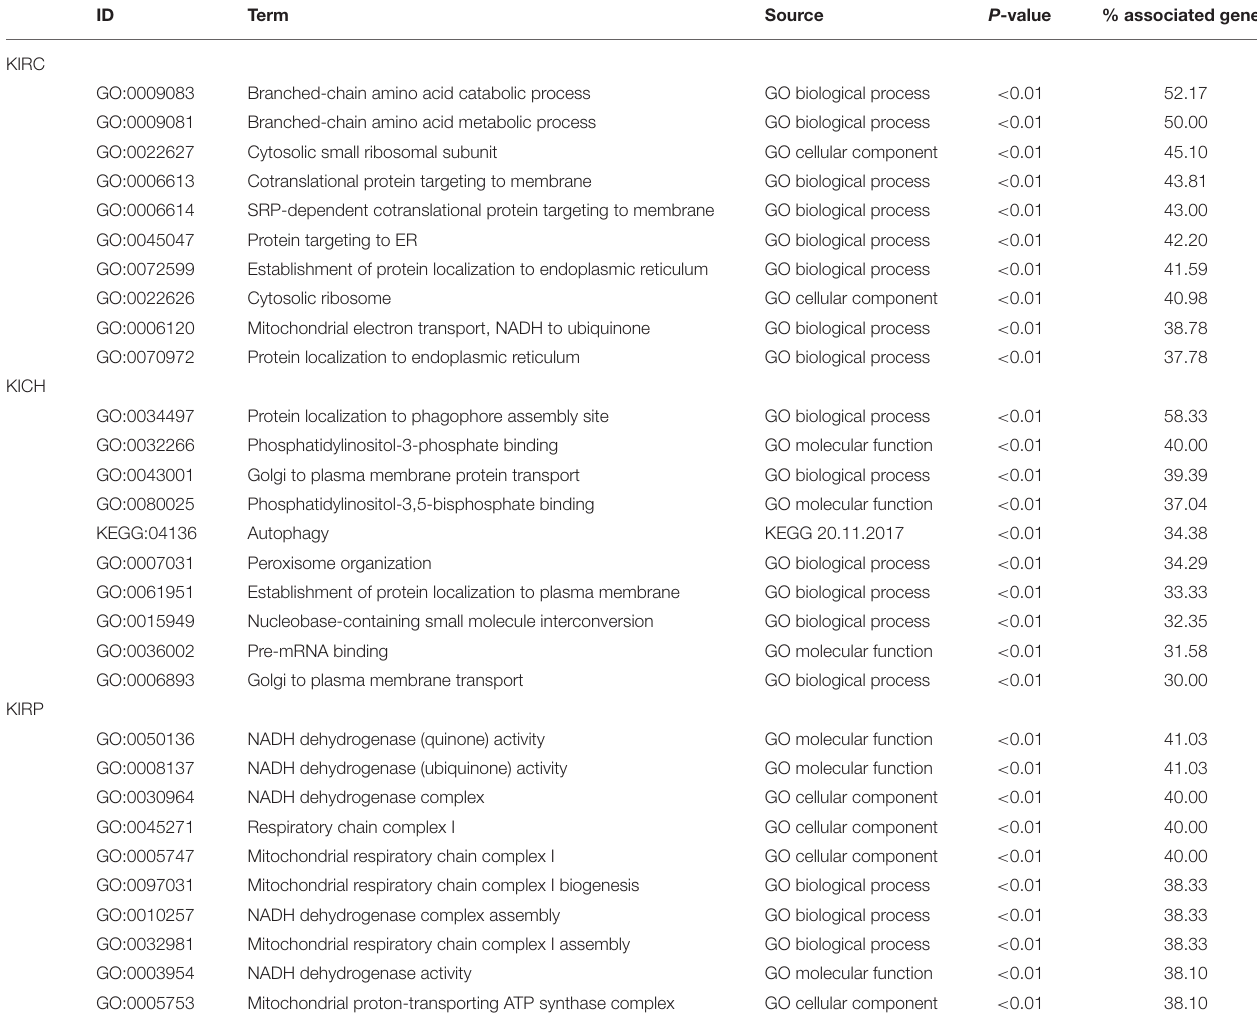
TABLE 3 | The information of GO terms with the highest